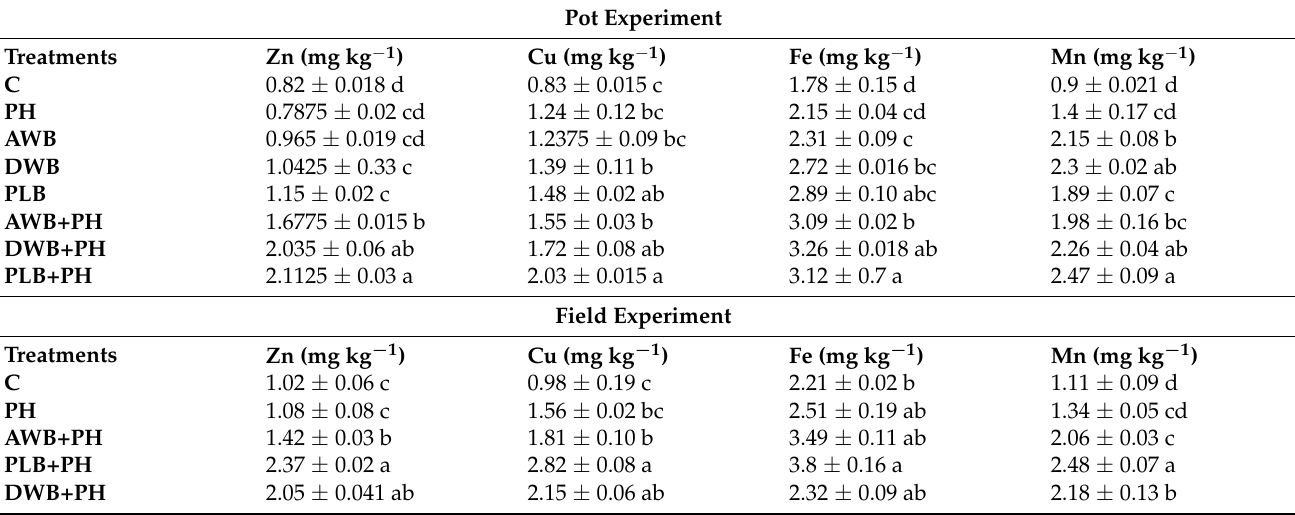
Table 4. Effect of each treatment on soil AB-DTPA extractable micronutrients under pot and field conditions. Pot